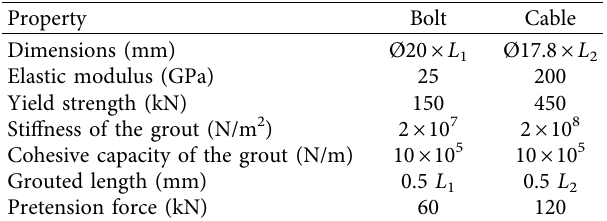
Table 3: Parameters of the supporting elements used in the nu- merical